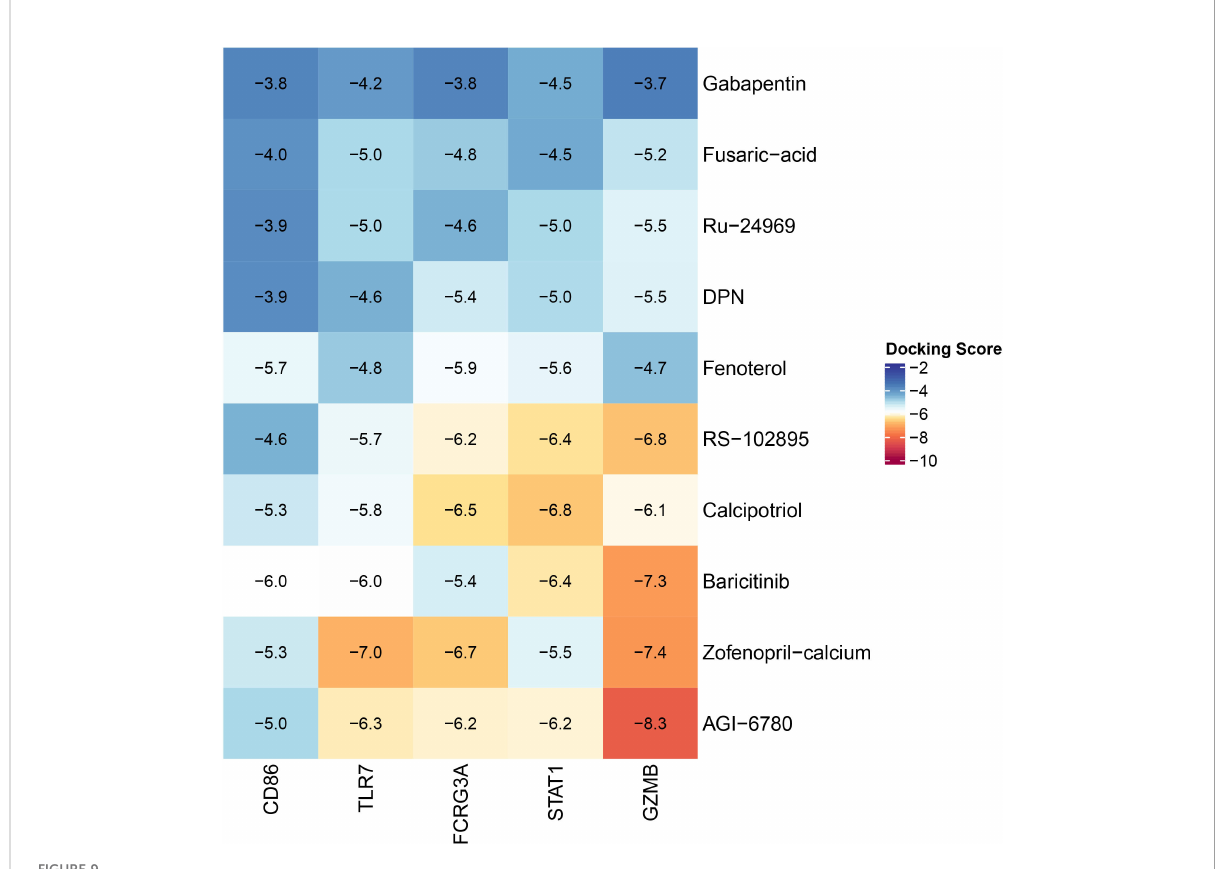
FIGURE 9 Heat map of the lowest binding energy for molecular